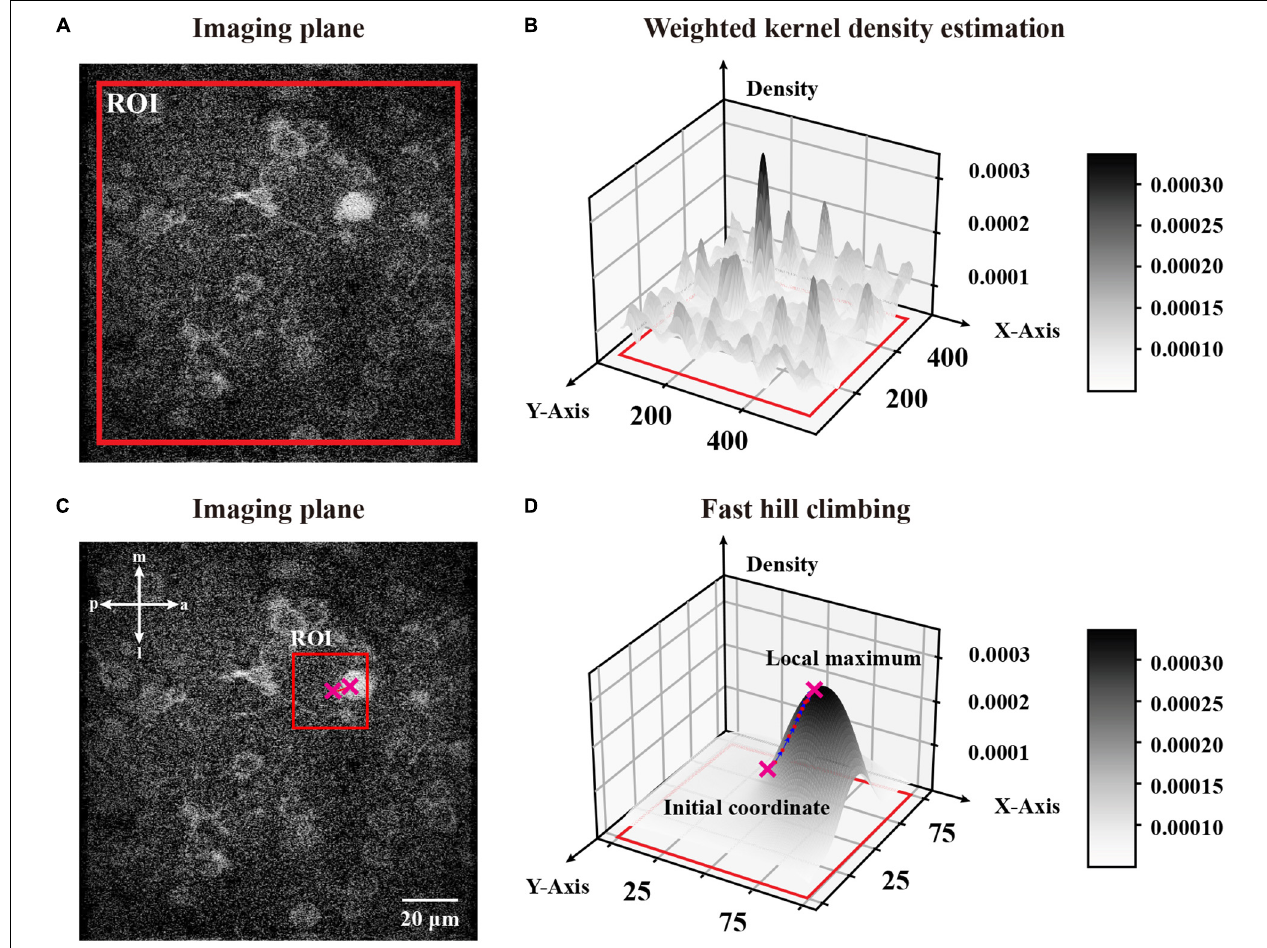
FIGURE 3 | A global W-KDE for a two-photon image and a visual demonstration of fast hill climbing to update initial coordinates. (A) A representative two-photon image within a global range ROI marked in red. (B) A topography of global W-KDE. The density map indicated with the grayscale bar painted on the right. (C) An initial coordinate obtained from sampled FAST features with a 101 pixels-sized ROI centered by it. We mark the ROI in red and plot the initial coordinate and the local maximum with crosses that are also plotted in panel (D) . (D) A W-KDE of this ROI is to reveal the topography and process of fast hill climbing. The density map is indicated with the grayscale bar painted on the right. Each iteration of this feature is marked on the topography by pink